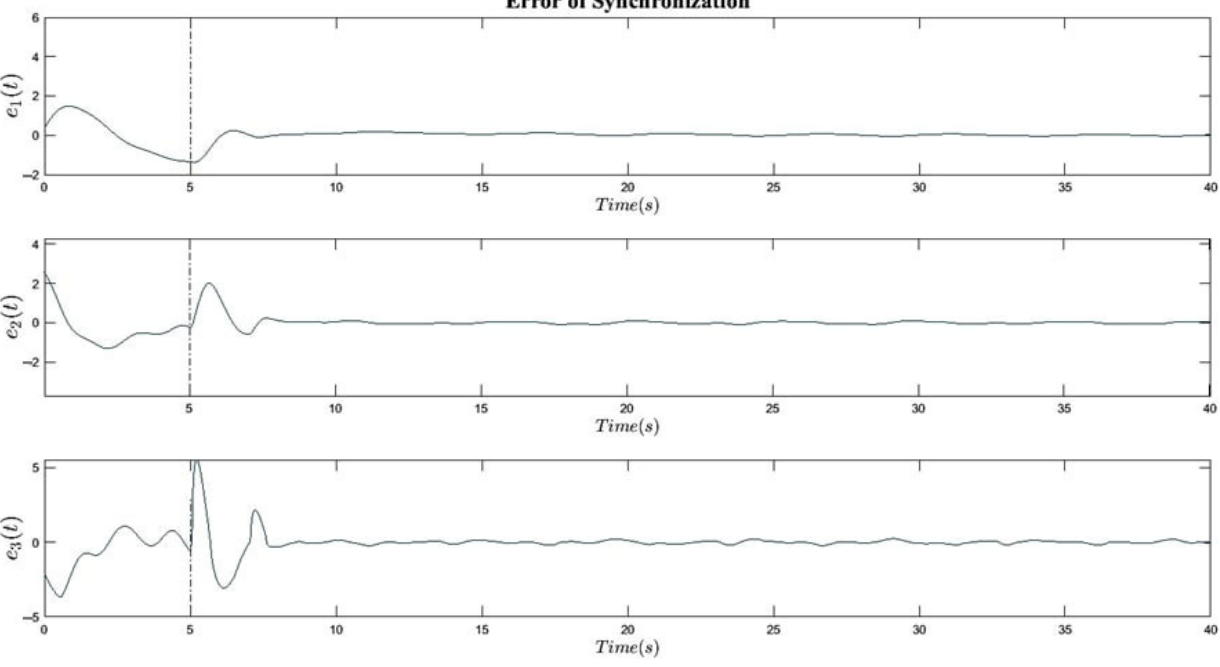
Figure 5. The control signal based on the proposed adaptive sliding mode control.